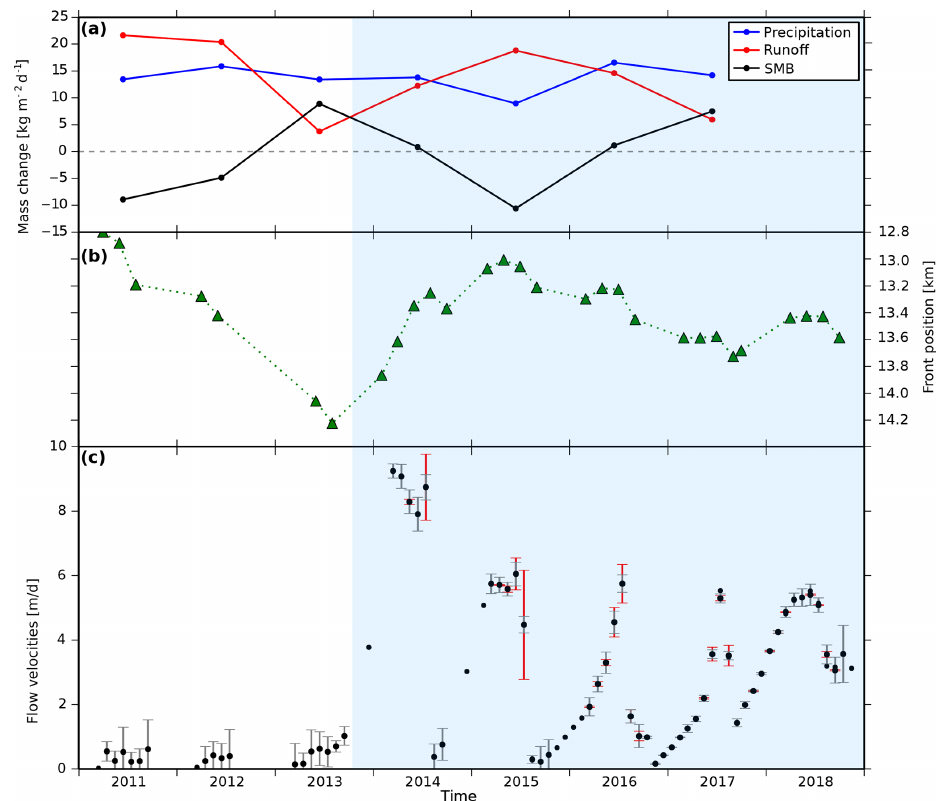
Figure 6. (a) Yearly precipitation, meltwater runoff and SMB averaged over the drainage basin. (b) Monthly front position with respect to the year 1916 digitized in Landsat images where available. (c) Monthly glacier velocity and its uncertainty estimate derived from the Landsat data set at a point close to the terminus of Harald Moltke Bræ (black triangle in Fig. 1). Red error bars indicate the standard deviations of monthly velocity values from different data sets. The surges are marked by light blue